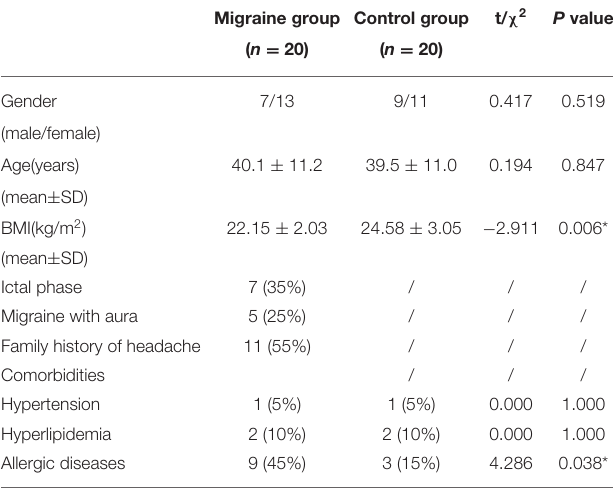
TABLE 1 | Characteristics of patients with migraine and controls. Migraine group Control